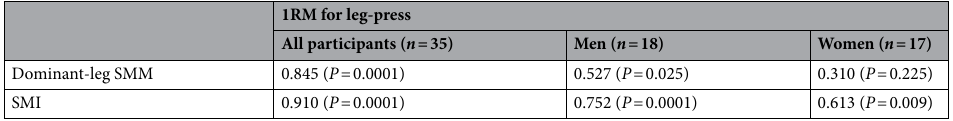
Table 2. Correlation analyses between BIA measurements and 1RM for leg-press. 1RM one-repetition maximum, BIA bioelectrical impedance analysis, SMI skeletal muscle mass index, SMM skeletal muscle mass.